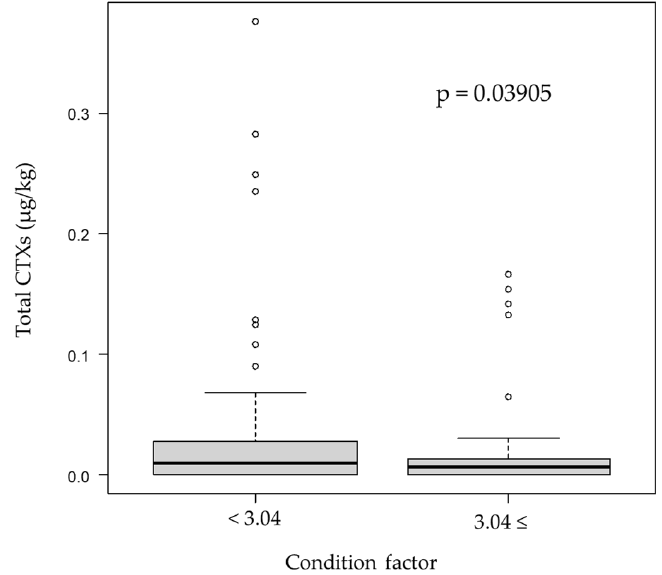
Figure 7. Total CTX levels in the flesh of V. louti specimens collected from Ryukyu Island, Japan, classified into two groups using the median of the condition factor (3.04).